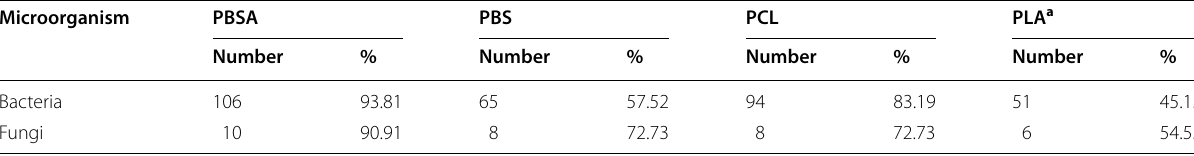
a Measured growth of microorganisms. Clear zones were not observed